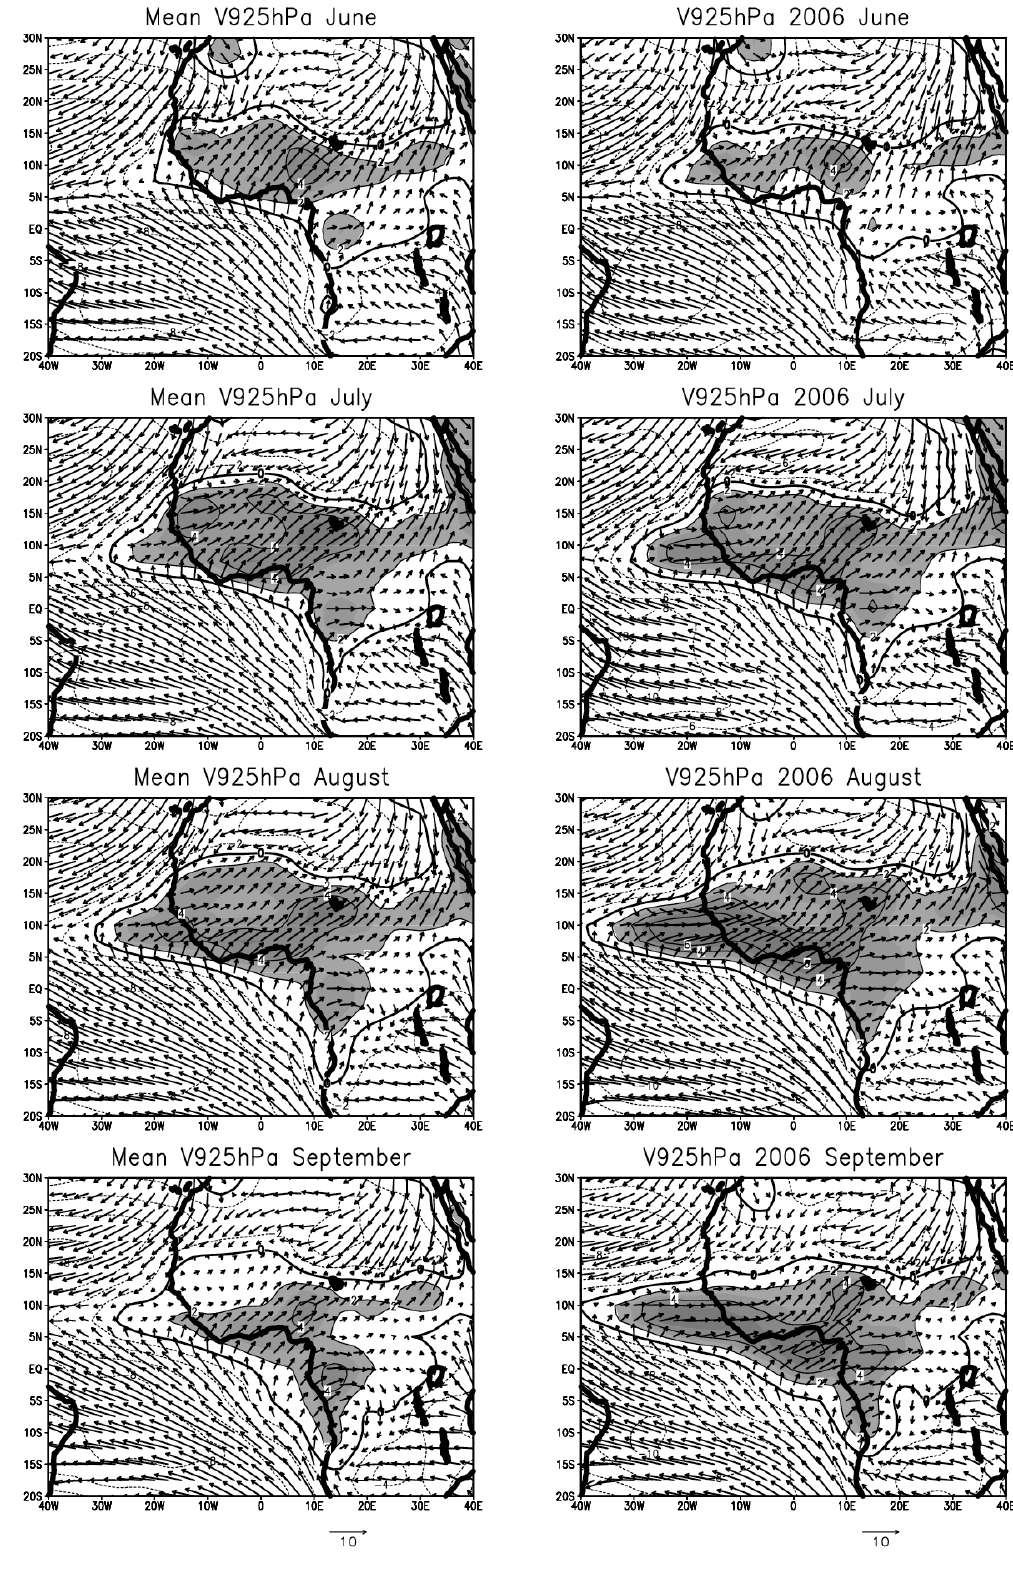
Figure 3. Left. 1979-1999 averaged wind fields at 925 hPa, in June, July, August, September Fig. 3. Left: 1979–1999 averaged wind fields at 925hPa, in June, July, August, September from NCEP. Right: Same wind fields but for from NCEP. Right. Same wind fields but for 2006. Shaded areas for westerly wind 2006. Shaded areas for westerly wind component higher than 2ms − 1 . The vector scale is component higher than 2 ms -1 . The vector scale is displayed.